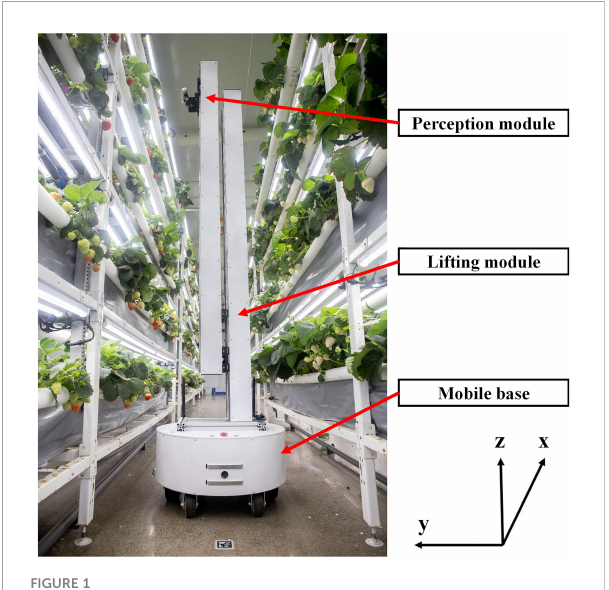
FIGURE 1 Hardware of the mobile robotics platform